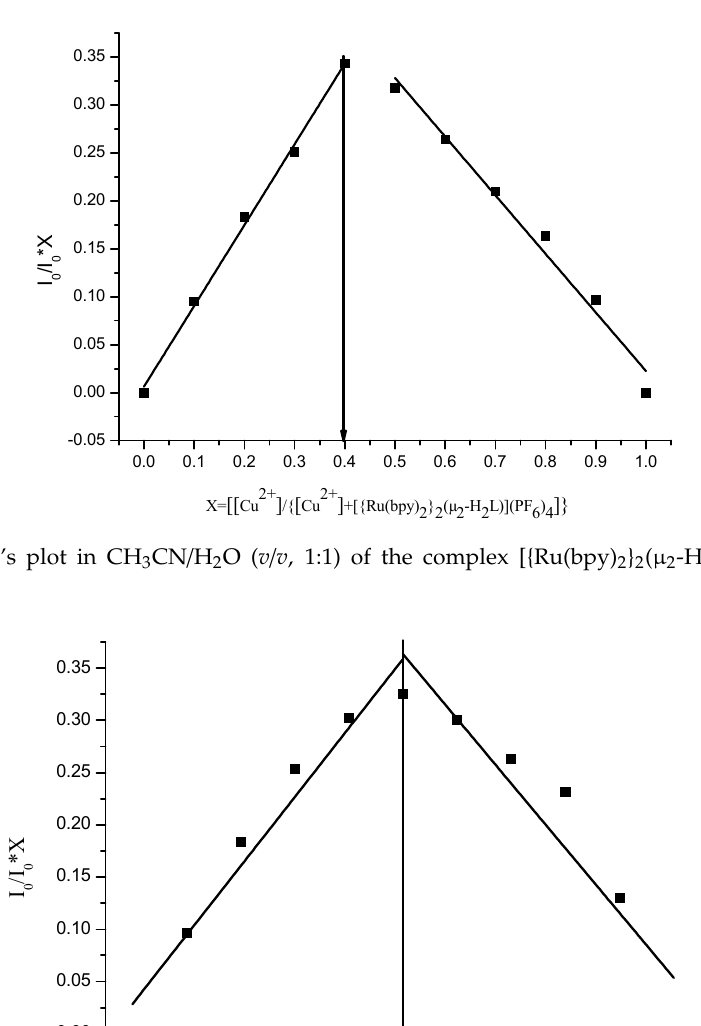
Figure 10. Jobs plot in CH 3 CN/H 2 O ( v / v , 1:1) of the complex [{Ru(bpy) 2 } 2 ( μ 2 -H 2 L)] 4+ and Fe 3+ binding.